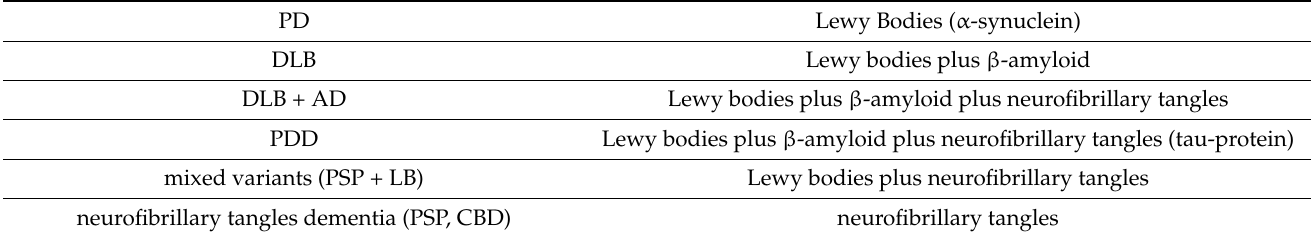
Table 1. Interactions of various pathological proteins and